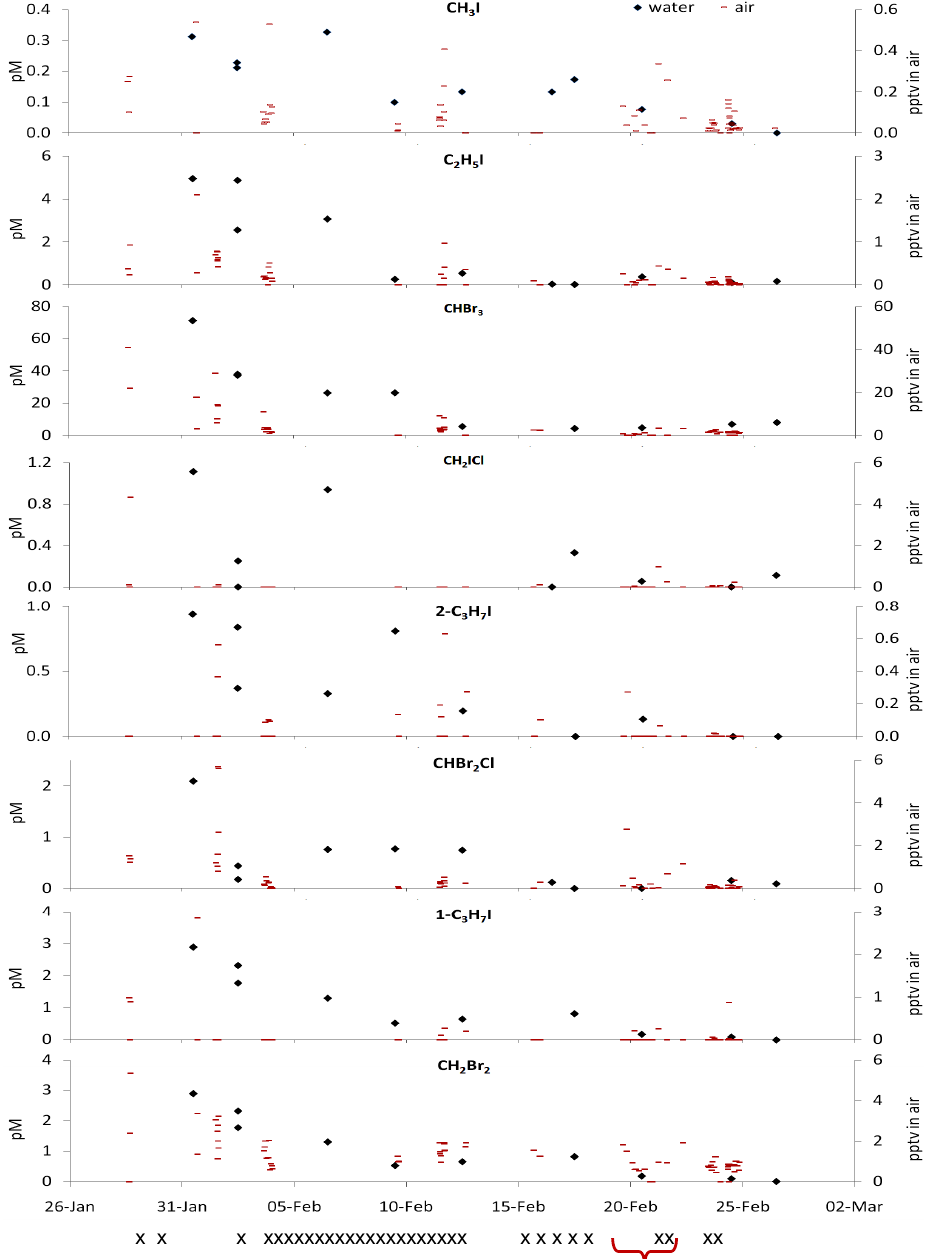
Fig. 8. Halocarbon concentrations in sea water samples (black diamonds), taken from the ship’s USW supply, and mixing ratios in air (red lines). CH 2 IBr was not present above the LoD. Air samples were taken from the Brunt Ice Shelf during the period denoted by the red downward-pointing bracket, black crosses indicate periods when sea ice varied between 1/10 and 10/10 around the ship.